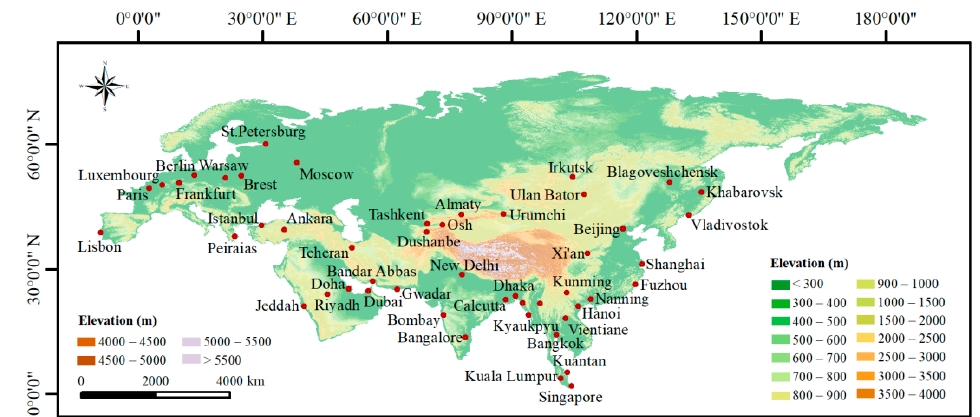
Figure 2. Elevation of the Eurasian continent. The Eurasia continent is the largest continental area on Earth. Primarily in the Northern and Eastern Hemispheres, it spans from the Iberian Peninsula in the west to the Russian Far East in the east, from the Tanjung Piai of Malaysia in the south to the Russian Taymyr Peninsula in the north. The mainland is bordered by the Arctic Ocean to the north, the Indian Ocean to the south, the Atlantic Ocean to the west, and the Pacific Ocean to the east.